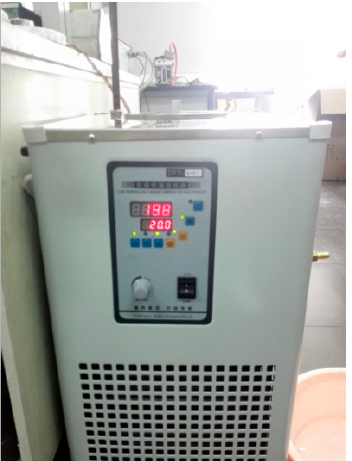
Figure 4. Device of the low-constant temperature.